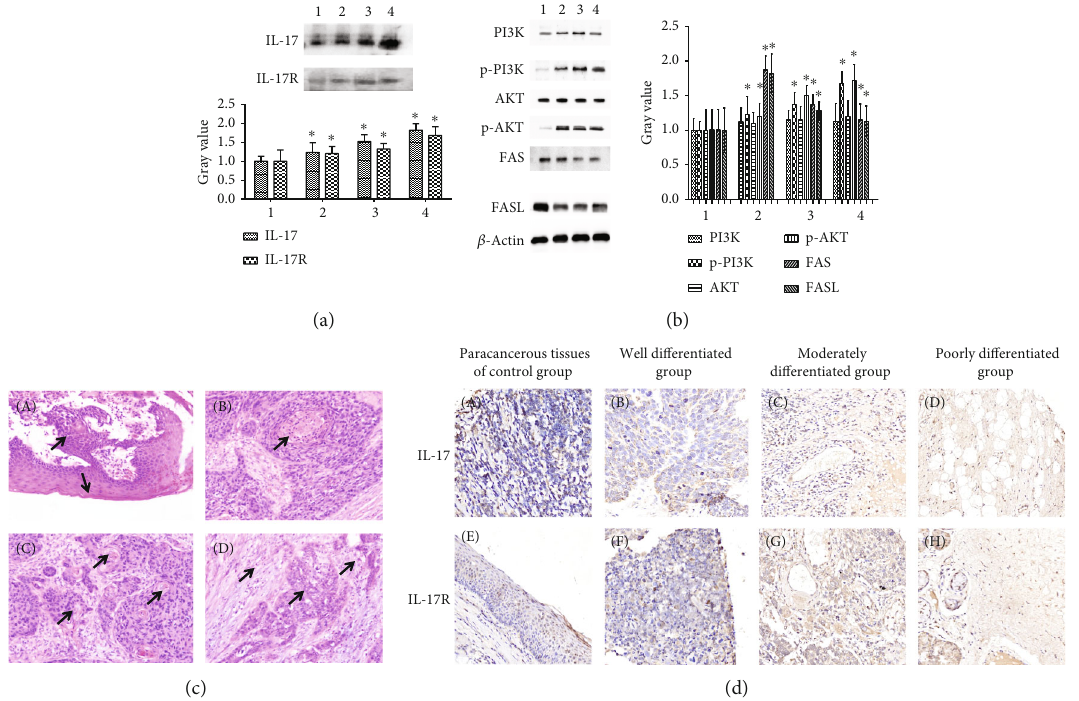
Figure 1: Western blotting analysis was used for time course analysis of IL-17, IL-17R, P-AKT, P-PI3K, FAS, and FASL protein expression in di ff erent pathological grades of LC tissues. (a) IL-17 and IL-17R protein expression in paracancerous tissues of the control group and di ff erent pathological grades of LC tissues. (b) P-AKT, P-PI3K, FAS, and FASL protein expression in paracancerous tissues of the normal control group and di ff erent pathological grades of LC tissues. The bar graph of protein quanti fi cation plotted from not < 3 independent experiments. The band intensity of IL-17, IL-17R, P-AKT, P-PI3K, FAS, and FASL was quanti fi ed by densitometry and normalized to β -actin. Densitometry values in the histograms were expressed as fold change relative to the normal control, which was assigned a value of 1. ∗ P < 0 : 01 compared with the control group. 1=paracancerous tissues of the control group, 2=well-di ff erentiated group, 3=moderately di ff erentiated group, and 4 =poorly di ff erentiated group. LC: laryngeal cancer. (c) LC, lymphocytic host response, and tumor in fi ltrative lymphocytes. (A) Arrows show paracancerous tissues of the control group with pushing invasive tumor front and band-like dense in fl ammatory in fi ltrates. H&E,400x. (B) Arrows show the well-di ff erentiated group demonstrating minimal lymphocytic host response. H&E, 400x. (C) Arrows show the moderately di ff erentiated group with a more intense lymphocytic host response. H&E, 400x. (D) Arrows show tumor-in fi ltrating lymphocytes in the poorly di ff erentiated group. H&E, 400x. H&E: hematoxylin and eosin. (d) IHC analysis of IL- 17 and IL-17R protein expression levels in LC tissues from patients at di ff erent pathologic grading. The (A – D) indicated IL-17 expression in LC tissues from patients with di ff erent pathologic grading. The (E – H) indicated IL-17R expression in LC tissues from patients with di ff erent pathologic grading. Scale bar = 50 μ m . ∗ P ≤ 0 : 05